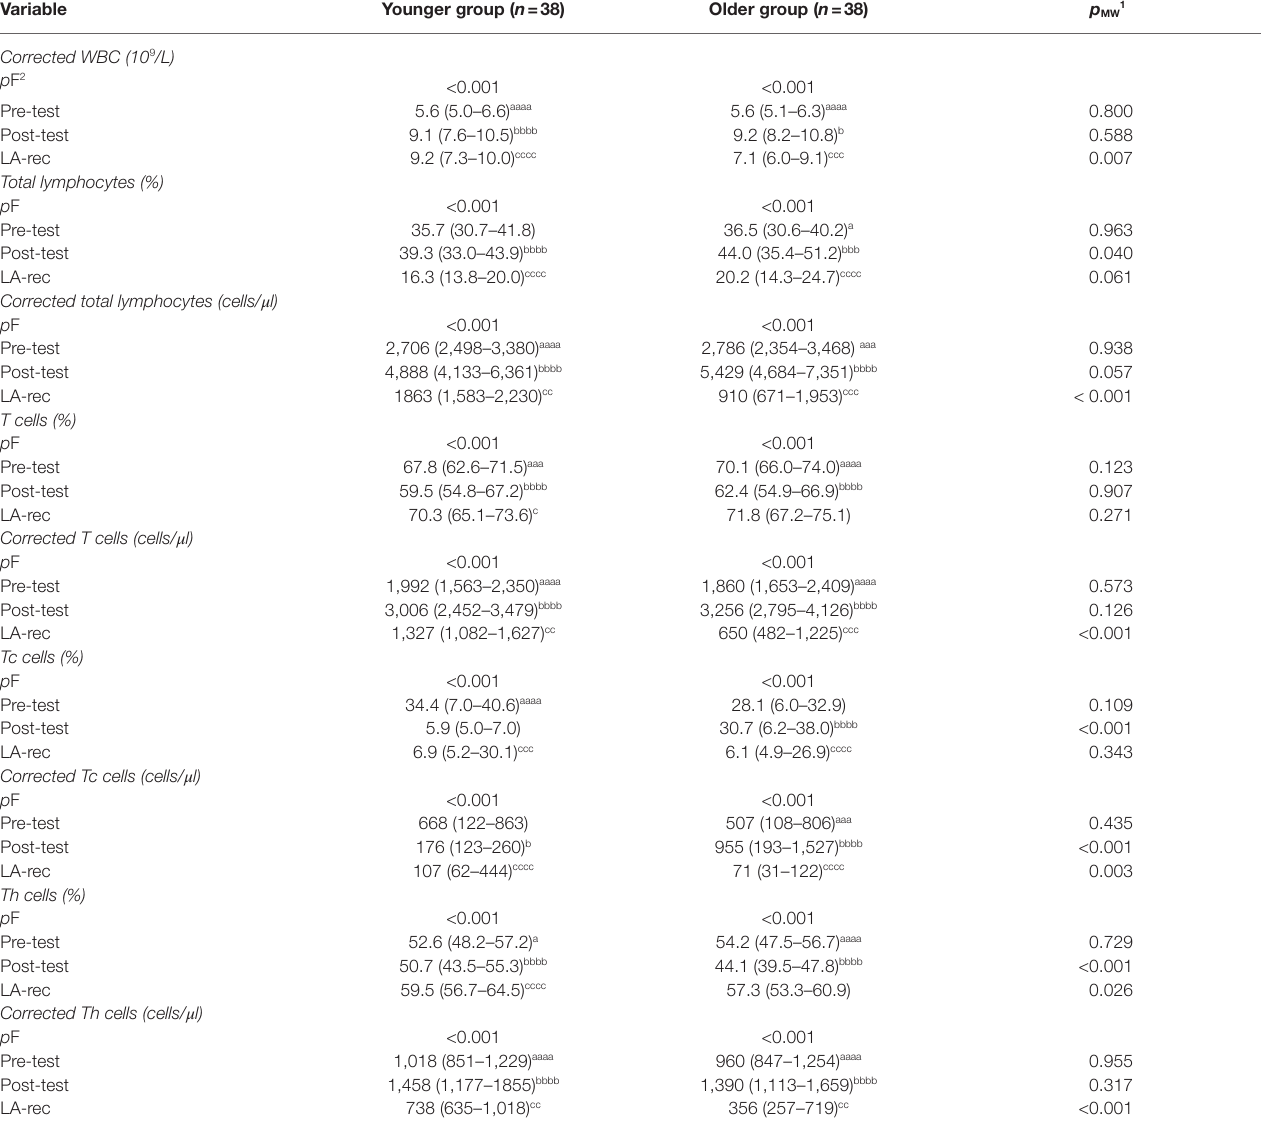
TABLE 3 | White blood cell (WBC), total lymphocyte, and T cell subset (T cytotoxic cells, Tc and T helper cells, Th) counts or percentage distribution in peripheral blood of the participants. Variable Younger group ( n = 38) Older group ( n = 38) Corrected WBC (10 9 /L) p F